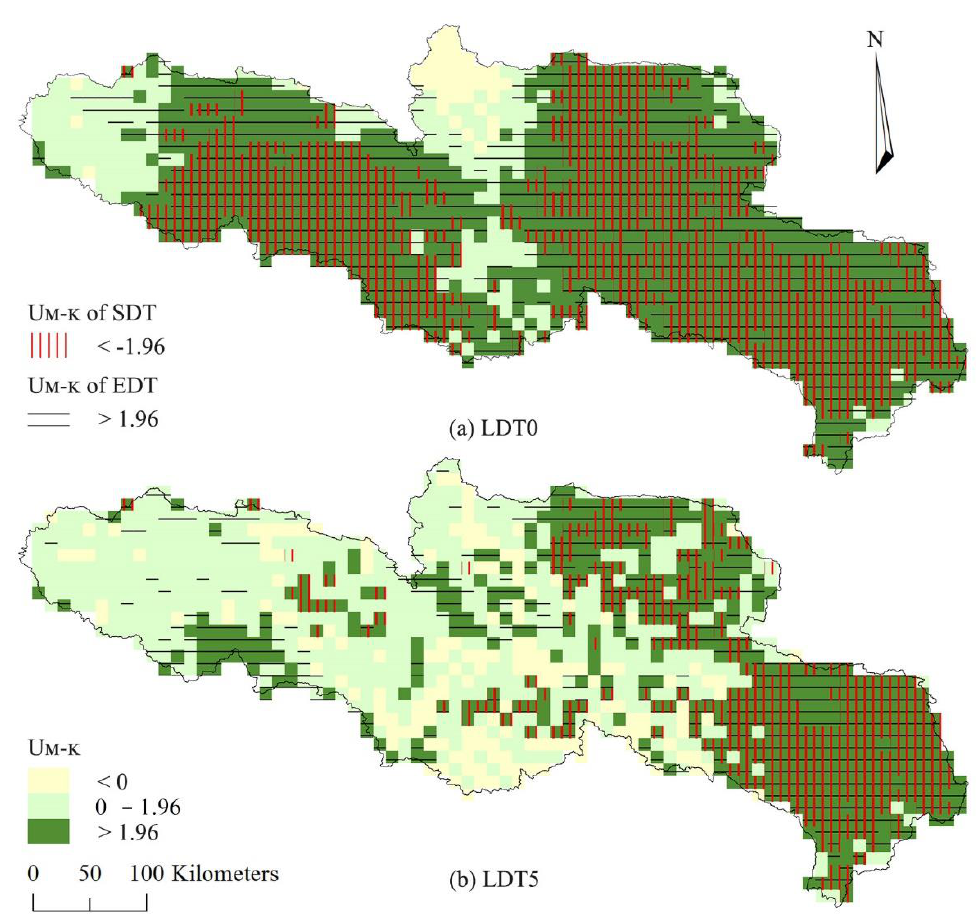
Figure 6. The trends of the lasting days with mean daily temperature ≥ 0 ◦ C ( a ) and ≥ 5 ◦ C ( b ) and the distribution with significant trends in the start day (red vertical line) and end day (black horizontal line) during 1979–2018 in the source region of the Yellow River. Table 8. The area of significant increasing trends in the SDT (start day of mean daily temperature